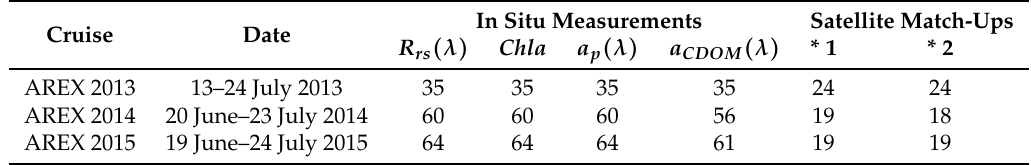
Table 1. Number of surface measurements of R rs ( λ ) , Chla , a p ( λ ) and a CDOM ( λ ) made during each of the three cruises that were taken into consideration for the formulation of the algorithm. The numbers of the datasets in Table 4 are indicated by an asterisk *, because the number of match-ups varied for the two atmospheric correction